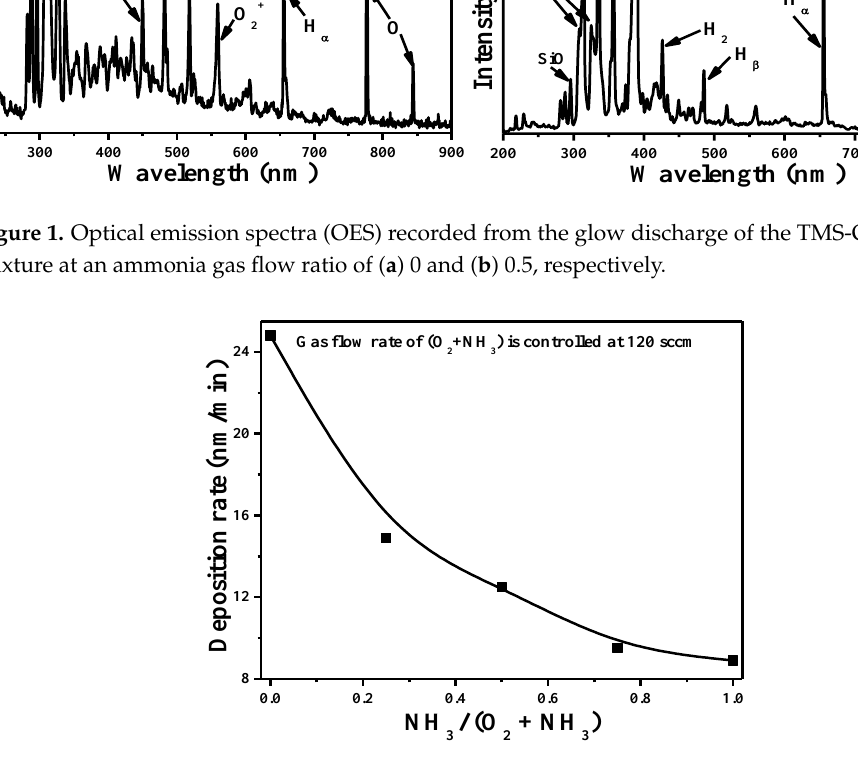
Figure 2. Deposition rates of the films as a function of the ammonia gas flow ratio in the glow discharge.